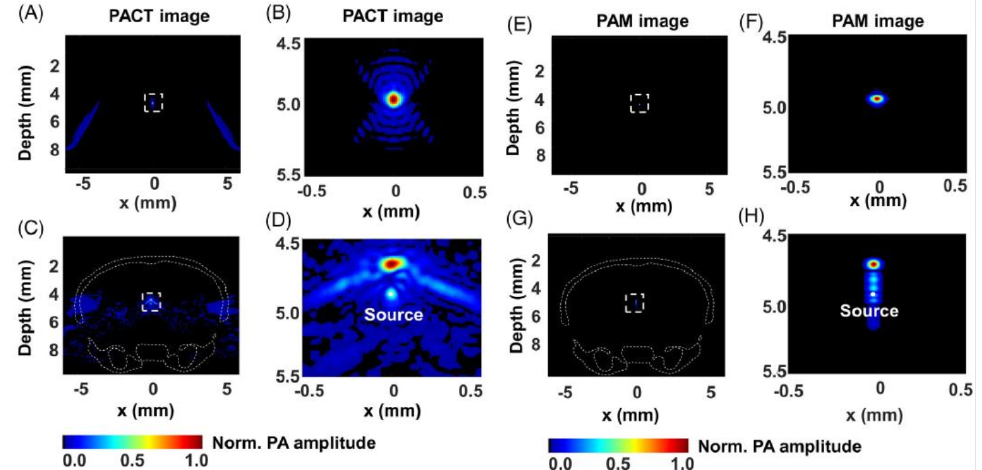
Figure 5. Simulated transcranial PAM and PACT images of a point target in water and skull cavity. ( A ) Full PACT image of the point target in water. ( B ) A close-up image of the region indicated by the dashed box in ( A ). ( C ) Full PACT image of the point target in water within the skull. ( D ) A close-up image of the region indicated by the dashed box in ( C ). ( E ) PAM image of the point source in water. ( F ) A close-up image of the region indicated by the dashed box in ( E ). ( G ) Full PAM image of the point target in water enclosed by the skull. ( H ) A close-up image of the region indicated by the dashed box in ( G ). The white dots in ( D , H ) represent the correct location of the point target (Reprinted with permission from Ref. [83]. 2019,